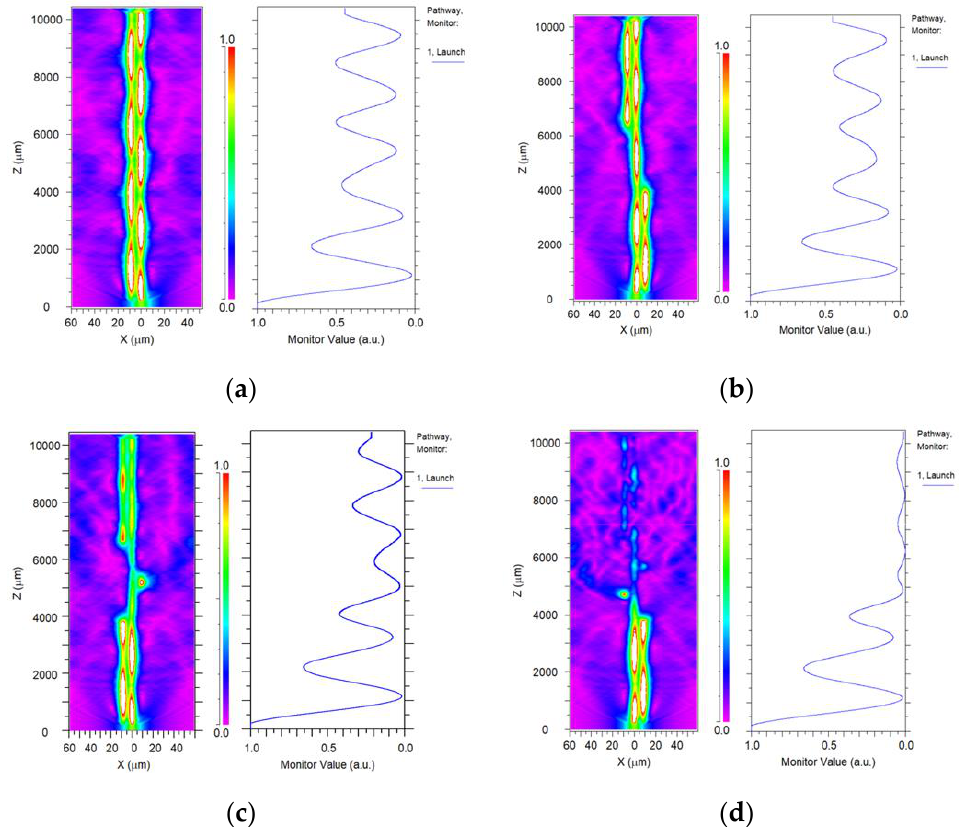
Figure 3. Simulation of power output under different torsion angles: ( a ) 0° ( b ) 180° ( c ) 360° ( d ) 540°.